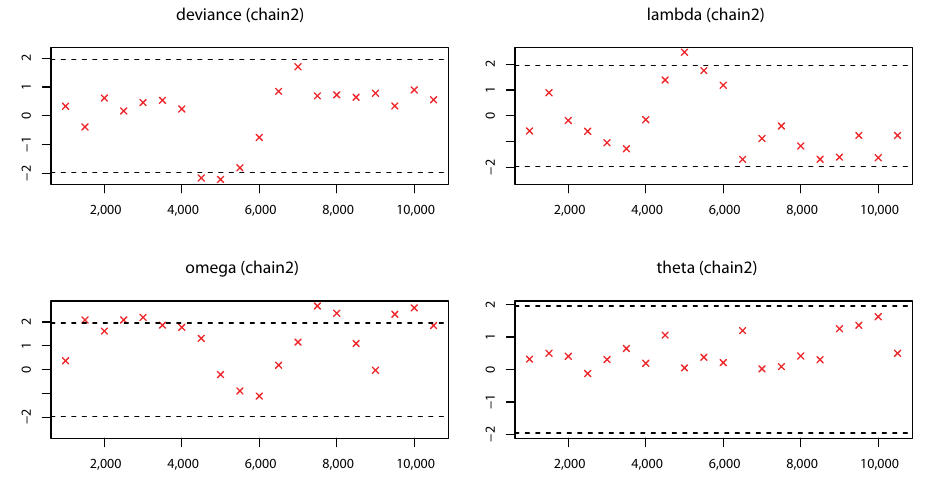
Figure 10. Geweke plot diagnostic (chain1) for each CWE distribution parameter based on DS1 dataset.